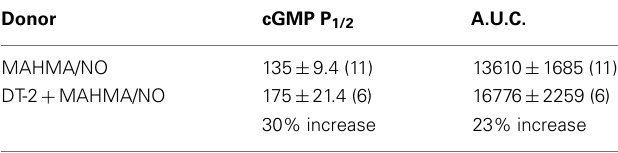
Table 2 |The effect of P-PDE5 on cGMP